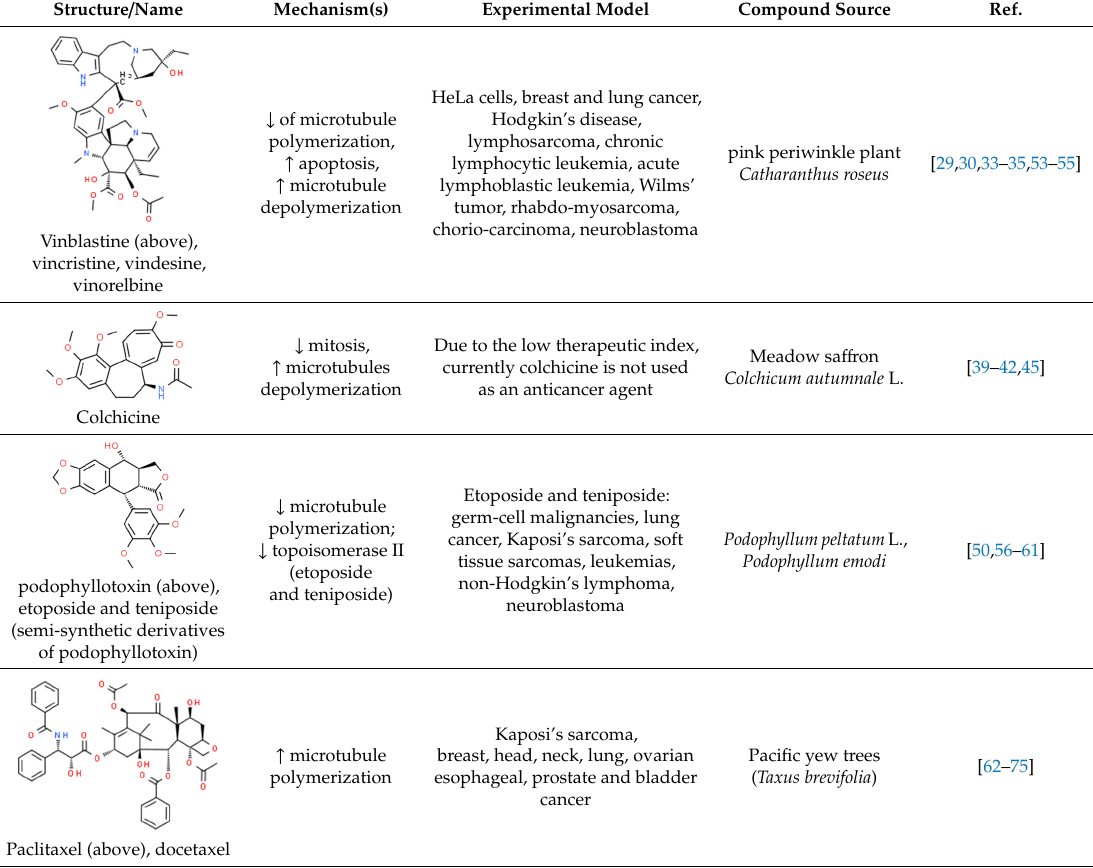
Table 1. The mitotic inhibitors—a brief summary. Images of the chemical structures obtained from